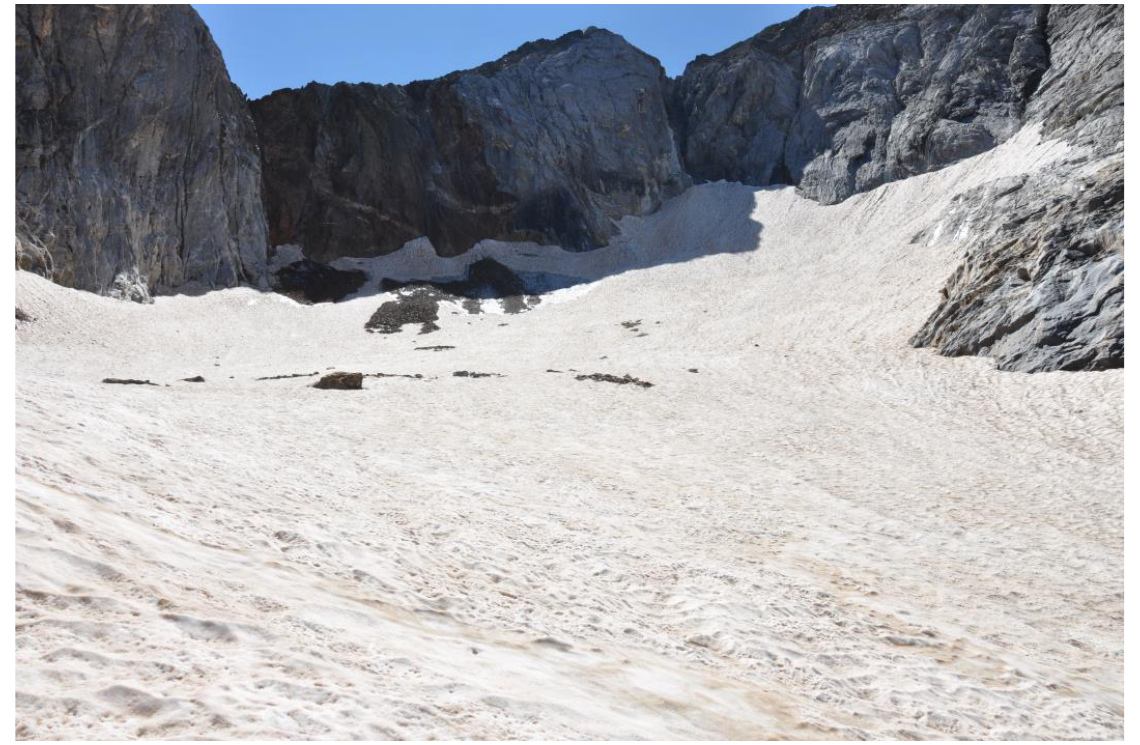
Figure 14. Detail of the Infierno Glacier; 1 September 2018. Most of the surface is covered with firn. Year 2019. Date of measurements: August